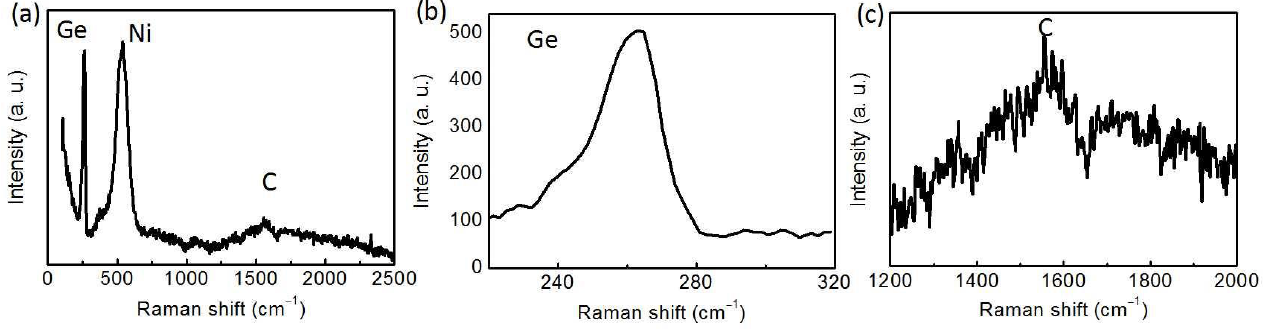
Figure 8. Raman spectra of the Ge composite film ( a ), Raman spectra of the Ge ( b ), and Raman spectra of the graphite ( c ).